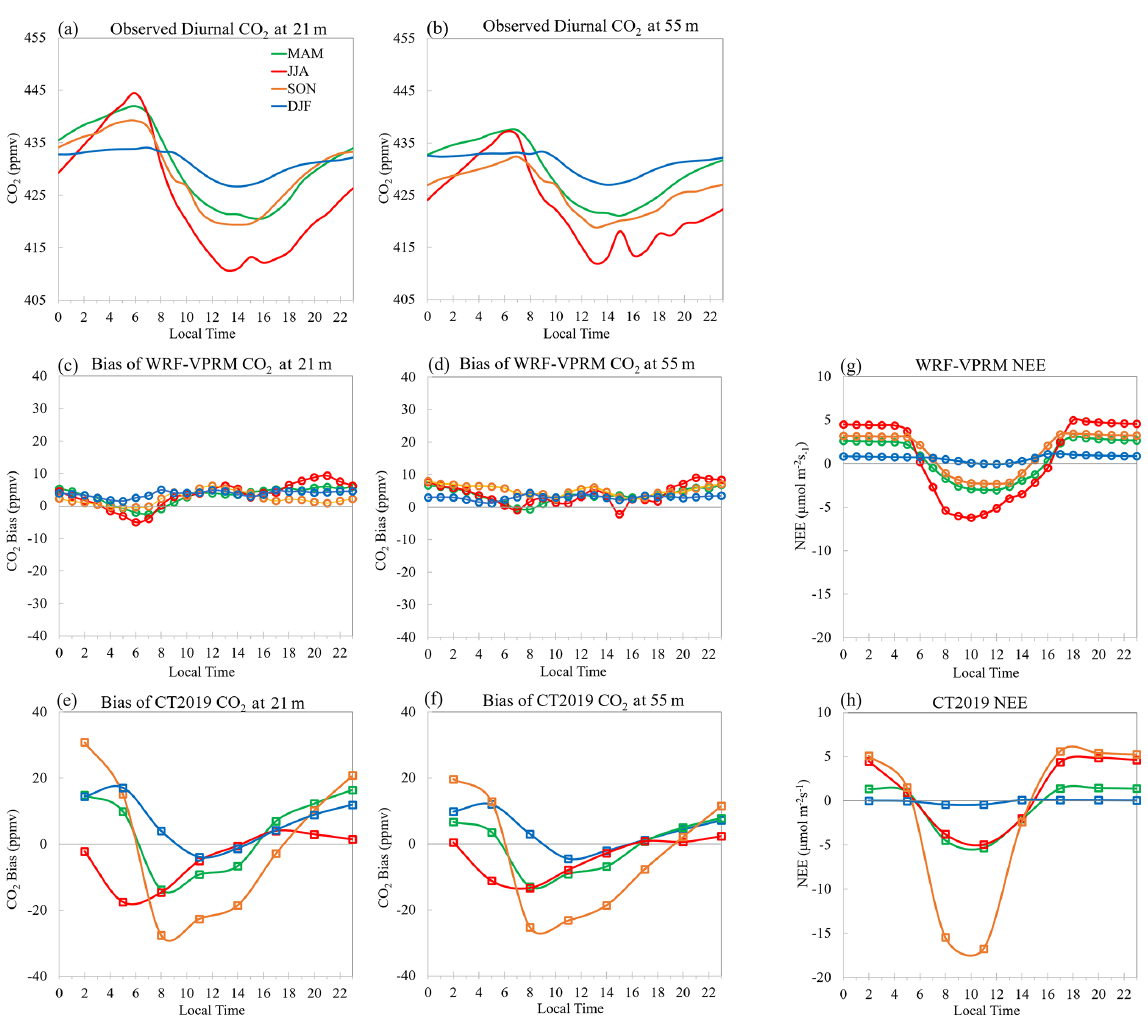
Figure 7. Seasonal mean diurnal variations of observed CO 2 at (a) 21m and (b) 55m. WRF-Chem simulation biases of CO 2 at (c) 21m and (d) 55m. CT2019-simulated biases at (e) 21m and (f) 55m. Simulated NEE from (g) WRF-Chem and (h)